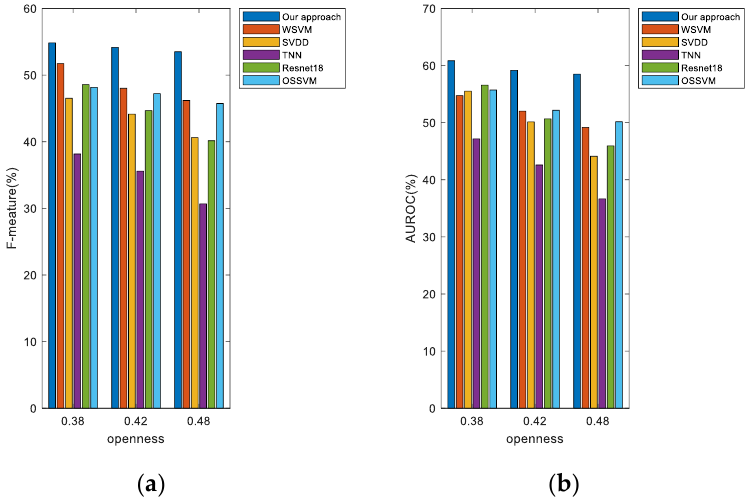
Figure 8. AUROC and F1-measure for open-set multi-class recognition in high-openness scenario: ( a ) F1-measure and ( b ) AUROC.